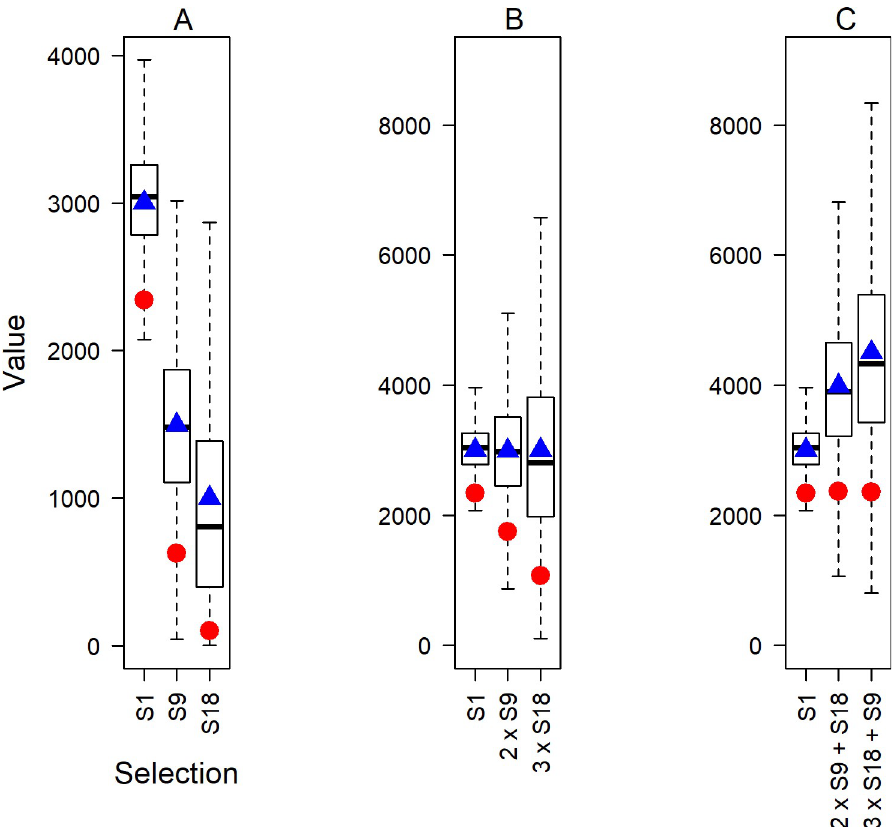
Fig 2. Draft value across alternative selections. Boxplots of draft value from a hypothetical example showing the mean (triangle), median (solid black line), central 50% of the distribution (box) and lower 5 th percentiles (circle). (A) The draft value from selections 1, 9 and 18 (S1, S9, and S18 respectively). (B) The draft value from selection 1 (S1), two of selection 9 (2 × S9), and three of selection 18 (3 × S18). (C) The draft value from selection 1 (S1), two of selection 9 and one selection 18 (2 × S9 + S18), and three of selection 18 and one selection 9 (3 × S18 + S9).